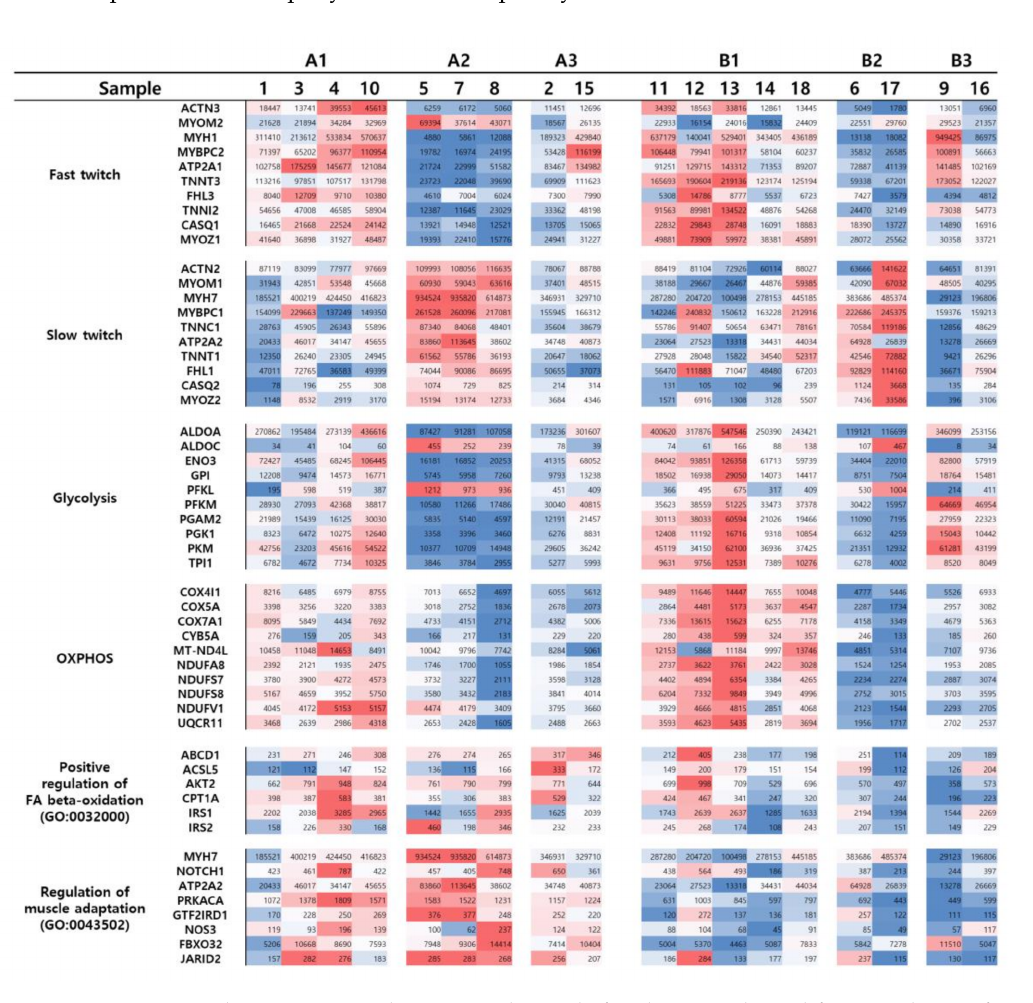
Figure 4. Expression heatmaps in each group and sample for slow-twitch- and fast-twitch-specific genes. The list of genes is based on the (i) fiber-type-specific genes from the literature base (TNNC2 and TNNI1 are not included because they do not have annotation ids in the reference), (ii) DEGs in IPA canonical pathways and GO, (iii) GO database (positive regulation of FA β -oxidation). The color of the heatmap for gene counts is blue for the lower percentile than 50 and red for higher than 50 (for each